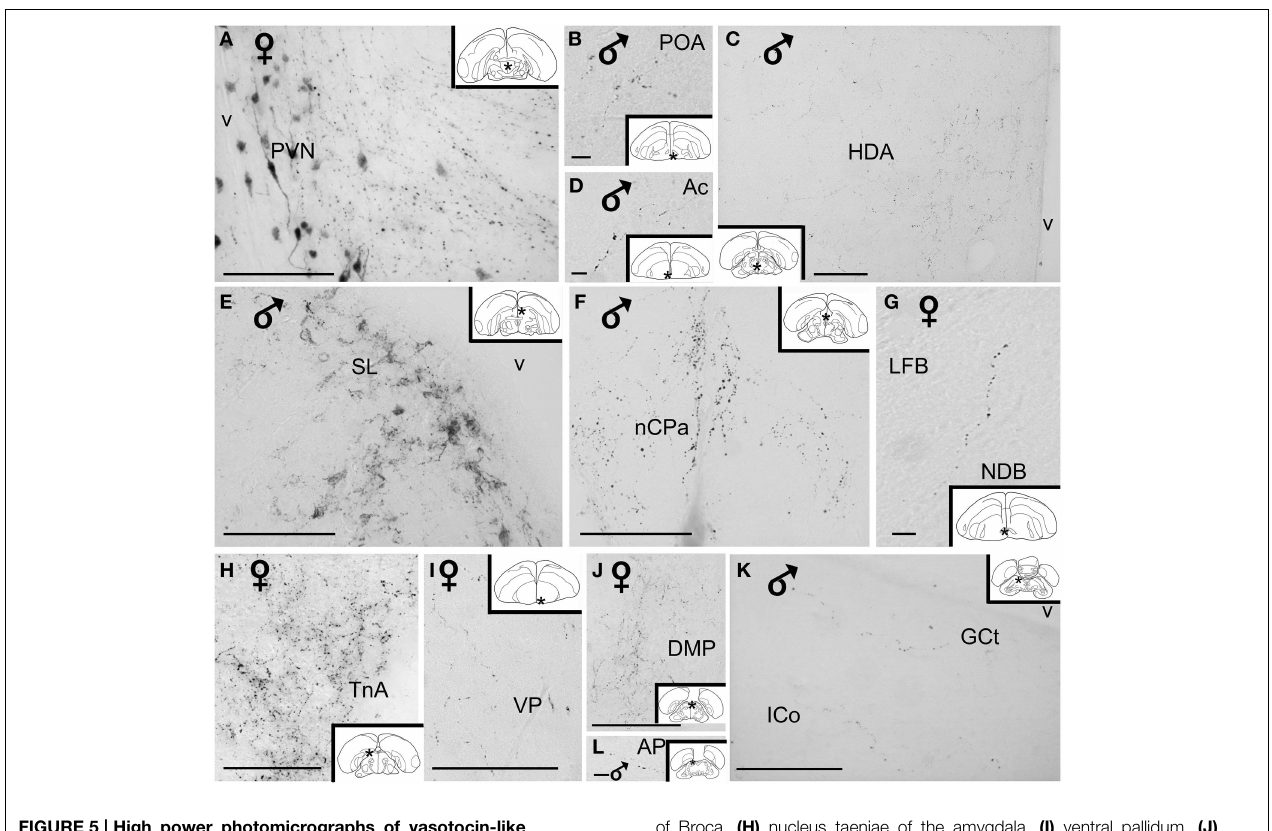
FIGURE 5 | High power photomicrographs of vasotocin-like immunoreactive fibers and terminal fields in the brain of the blue tit. (A) hypothalamic paraventricular nucleus, (B) preoptic area, (C) hypothalamic dorsal area, (D) nucleus accumbens, (E) lateral septum, (F) nucleus of the pallial commissure, (G) nucleus of the diagonal band